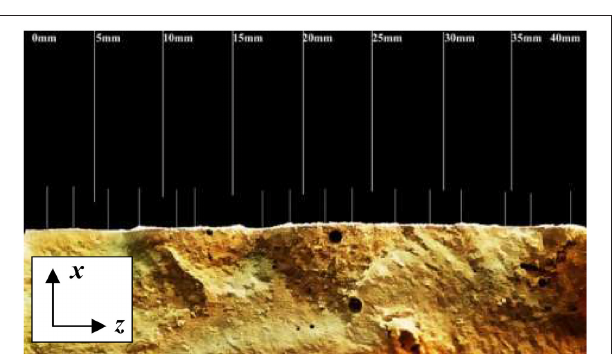
FIGURE 15 | The image of specimen’s fracture